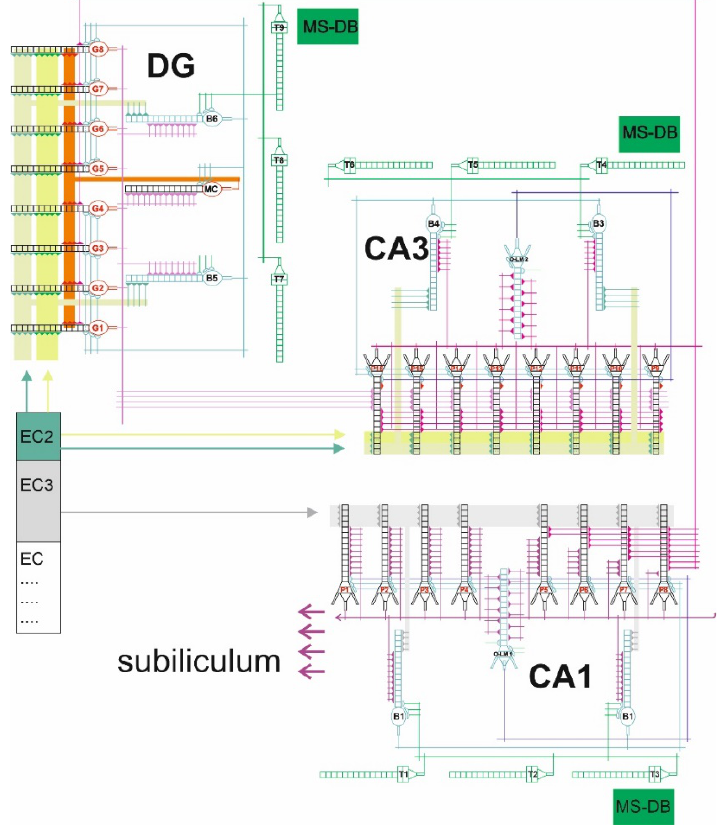
Figure 5. DG-CA3-CA1 hippocampal formation microcircuit, with the dentate gyrus (DG) region on the left, CA3 on the right and CA1 bottom. Major cell types and connectivity: (G1–G8)—granule cells, (P1–P16)—pyramidal cells, (B1–B6) basket cells, O-LM1 and O-LM2 cells, (MC) mossy cell, (T1–T9)—GABAergic cells in the medial-septum–diagonal band (MS-DB) which provides the disinhibitory inputs on hippocampal GABAergic interneurons at theta rhythm.